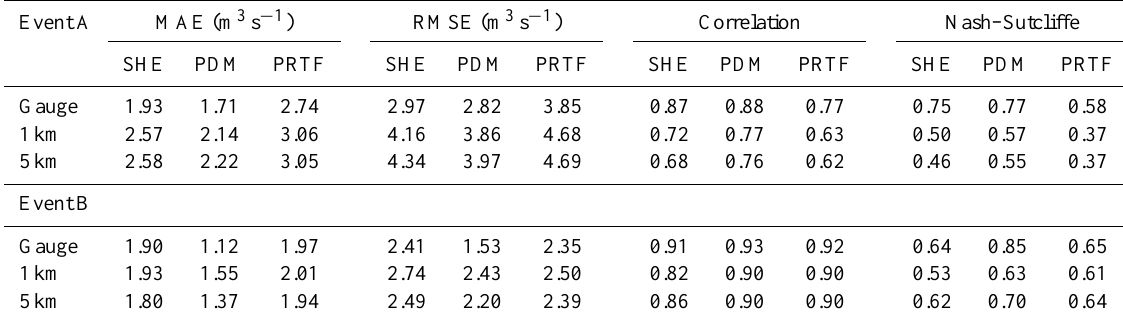
Table 3. Statistics of performance for different model output for frontal events. Event A Correlation Nash–Sutcliffe PDM PRTF SHE PDM PRTF PDM PRTF PDM PRTF